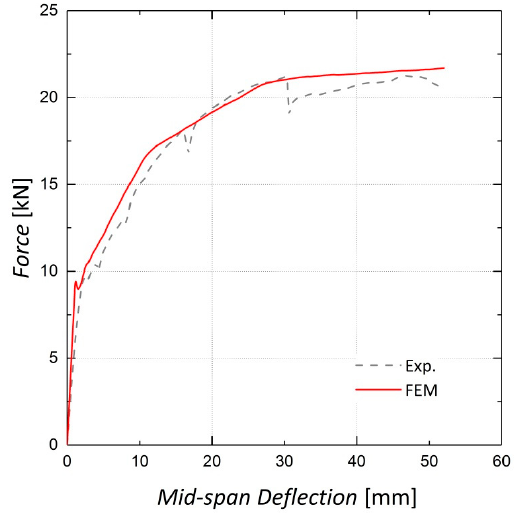
Figure 16. Finite Element analysis results for Beam 9 (non-prestressed).